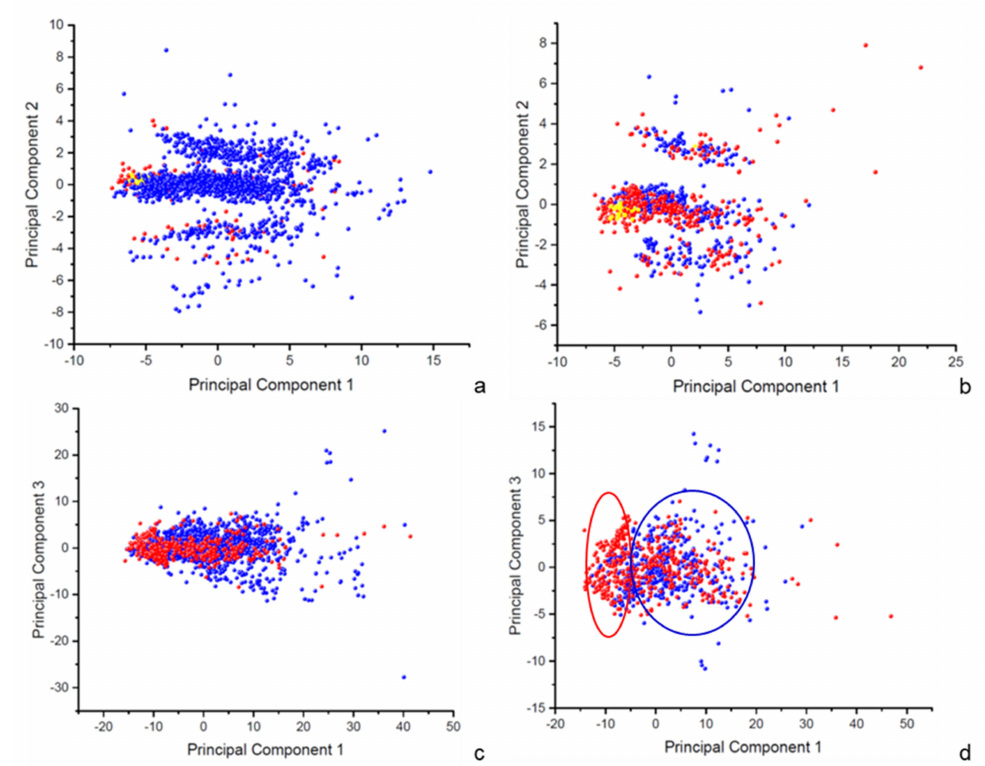
Figure 1. Scatter plots from PCA studies for MQ-dataset ( a , c ) for the first study and second study, respectively) and for the MT-dataset ( b , d ) for the first study and second study, respectively). “GSH substrates” and “GSH non-substrates” are displayed in red and blue, respectively. Yellow points correspond to the subset of known non-enzymatic GSH